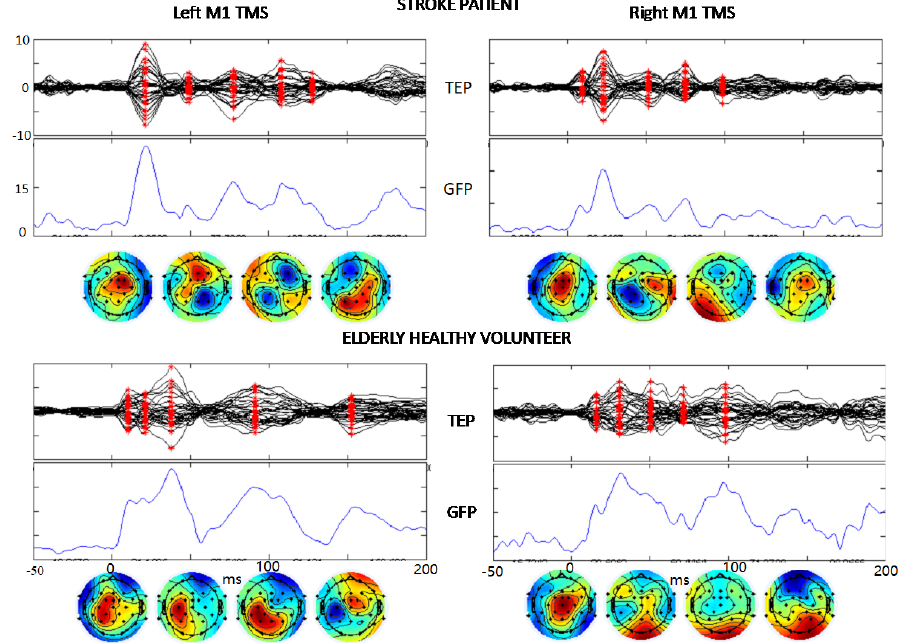
Figure 3. TEP description. The same structure of boxes from second to fourth rows of Figure 2 showing the TMS-evoked EEG potentials in a stroke patient and a healthy volunteer in response to the TMS stimulation of left and right M1 ( t = 0). The vertical scales are equal in the two hemispheres and both persons, μ V for TEP and μ V 2 for GFP.